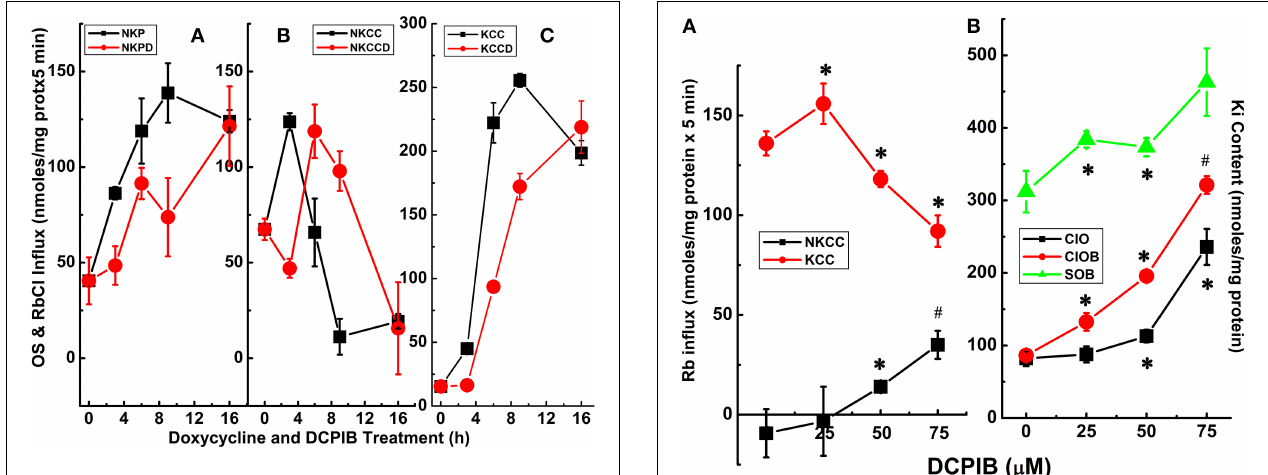
FIGURE 7 | Constitutive KCC3 Thr991/Thr1048 dephosphorylation elicits potent Rb + influx through ouabain-sensitive (NKP) and Cl-dependent (NKCC and KCC) pathways that are time-dependent and partially sensitive to DCPIB. Rb + influx was measured simultaneously with the K i contents of Figure 6 and as described in Materials and Methods, during induction with doxycycline (1 µ g/ml) and ± DCPIB (50 µ M). (A–C) Represent NKP, NKCC, and KCC without and with DCPIB (NKPD, NKCCD, and KCCD), respectively. Black squares in the absence and red circles in the presence of DCPIB. n = 3 –6 individual determinations. There was a statistically significant difference between groups as determined by One-Way ANOVA for NKP vs. NKPD [ F (8 , 19) = 26 . 06 ], NKCC vs. NKCCD [ F (8 , 21) = 41 . 81 ] and KCC vs. KCCD [ F (8 , 21) = 368 . 3 ], p < 0 . 0005 , n = 30 . Data represent the mean ± SEM values. Representative results from 4 similar experiments.